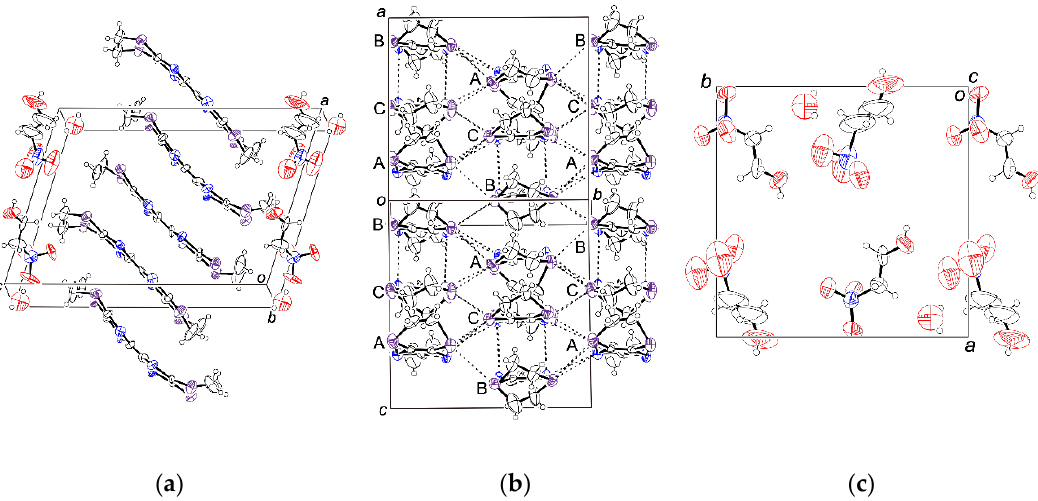
Figure 2. Crystal structure ( a ); arrangement of the donor layer ( b ), where dashed lines indicate short